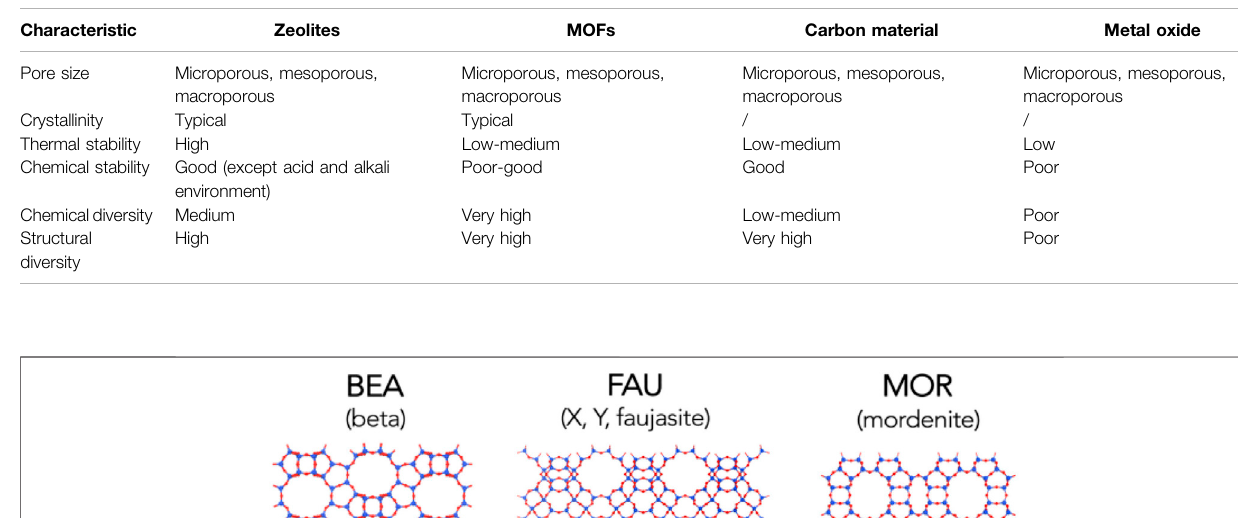
Frontiers in Chemistry |